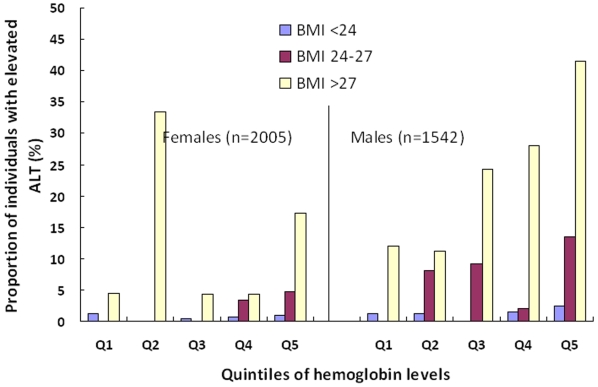
The proportion of individuals with abnormal alanine aminotransferase (ALT), categorized by body mass index (BMI) and quintiles of hemoglobin levels by gender.The total numbers of individuals with abnormal ALT are 29 and 83 cases among 2005 females and 1542 males, respectively.